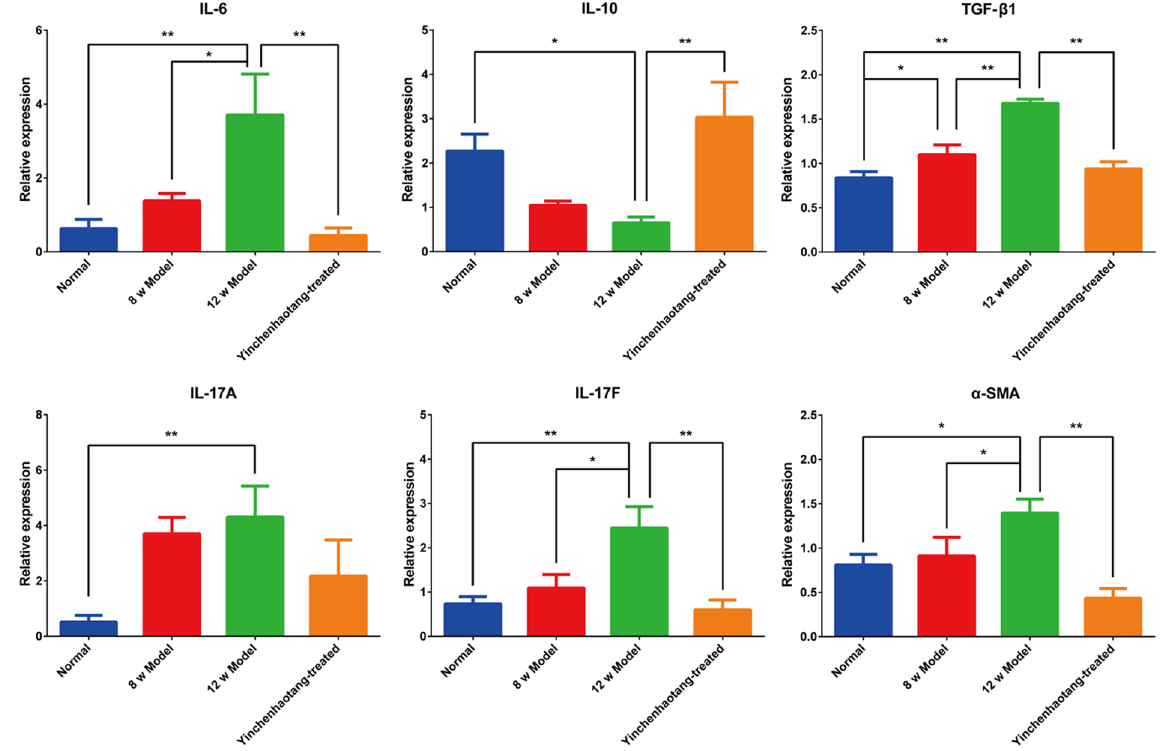
Figure 3. mRNA expression of IL-6, IL-10, TGF- β 1, IL-17A, IL-17F, and α -SMA in the liver. Normal, healthy rats; 8w Model, ANIT treatment for 8 weeks; 12w Model, ANIT treatment for 12 weeks; Yinchenhaotang- treated, ANIT-induced cholestasis rats treated with Yinchenhaotang from 9 th week to 12 th week. All data are presented as mean ± SEM. (n = 8–12; * P < 0.05; ** P <